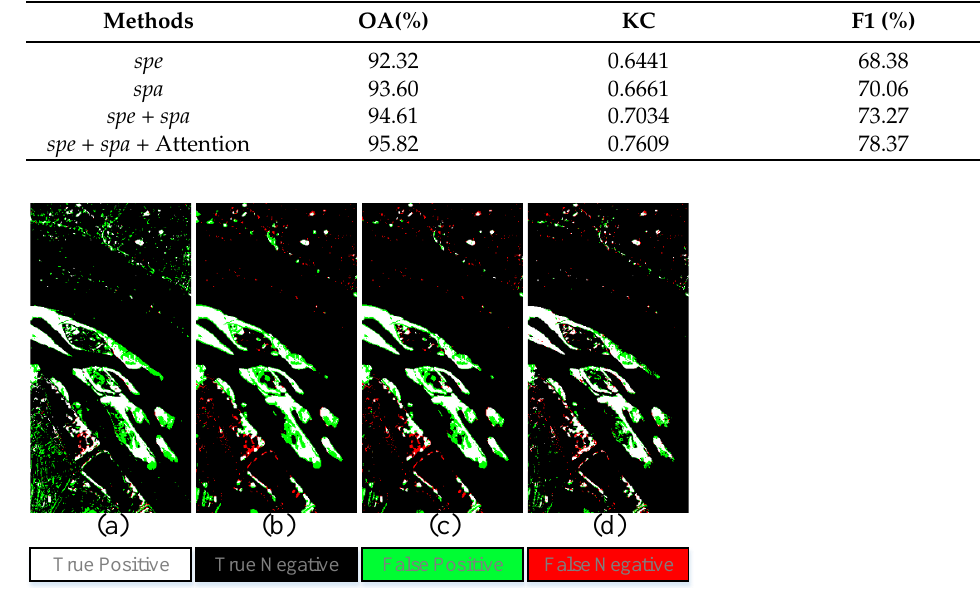
Figure 5. Visual results for ablation study of the combination of different features on the River dataset: ( a ) spe , ( b ) spa , ( c ) spe + spa , ( d ) spe + spa +